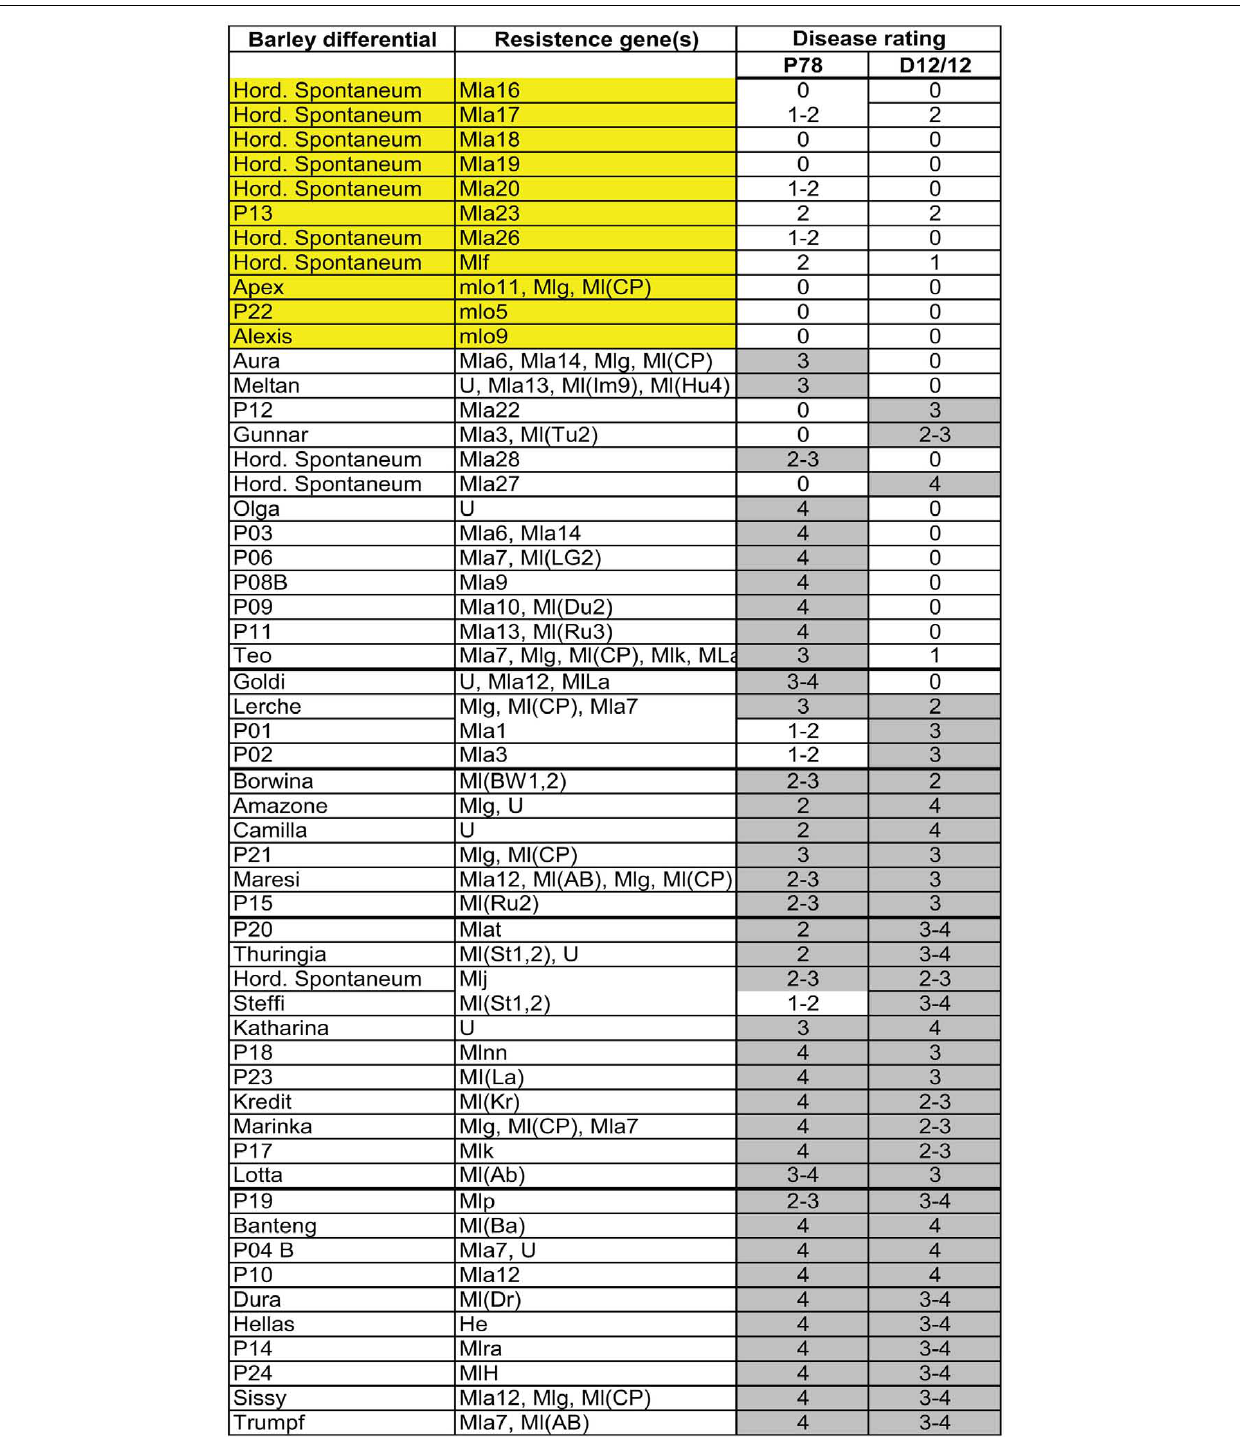
FIGUREA1 |Virulence spectrum of two polyvirulent German Bgh isolates. Disease symptoms were scored from 0 (resistant) to 4 (fully susceptible) using the scoring system as described (Jensen et al., 1992).